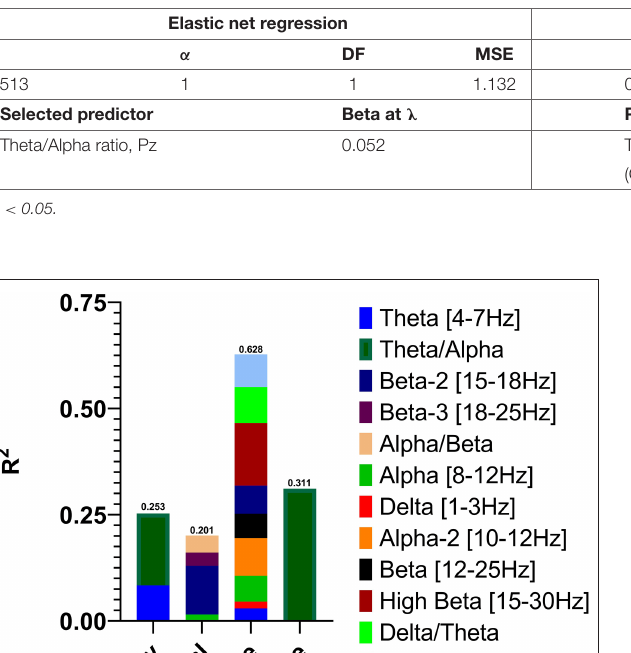
dataset to further validate their predictive capacity. All regression models were tested and are reported using standardized ( z